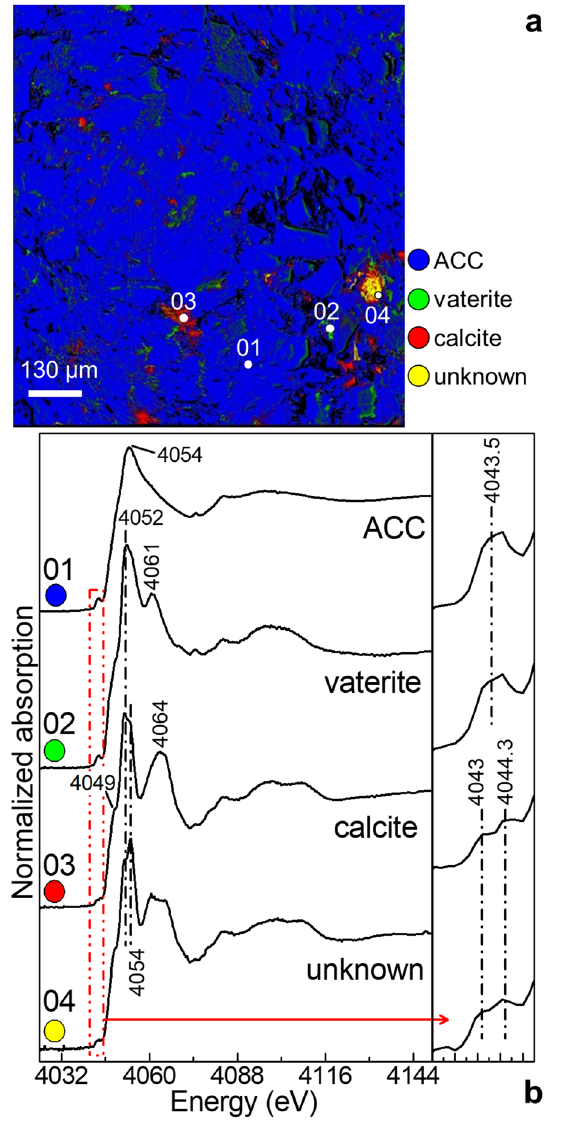
Figure 2. (a) Composite Ca phase maps obtained from the CFW consolidant aged at RH = 50% ( ∼ 10–20 µm in thickness) by least squares linear combination (LSLC) fit of the Ca K-edge FF-XANES stack, using the spectra of (red) calcite, (green) vaterite, (blue) ACC and (yellow) an unknown Ca-based compound as references [map size (h × v): 975.65 × 977.6 µm 2 ]. (b) Ca K-edge XANES spectra (black) extracted from the areas shown by white circles in (a) , and where the relative amount percentage of each phase is ≈ 95–100% [average pixel number: 5–20; pixel sizes (h × v): ~ 0.65 × 0.65 μm 2 ]. The inset on the right-side shows the pre-edge absorption region pointed out by the red dotted rectangle. Data were processed by means of TXM-Wizard 40